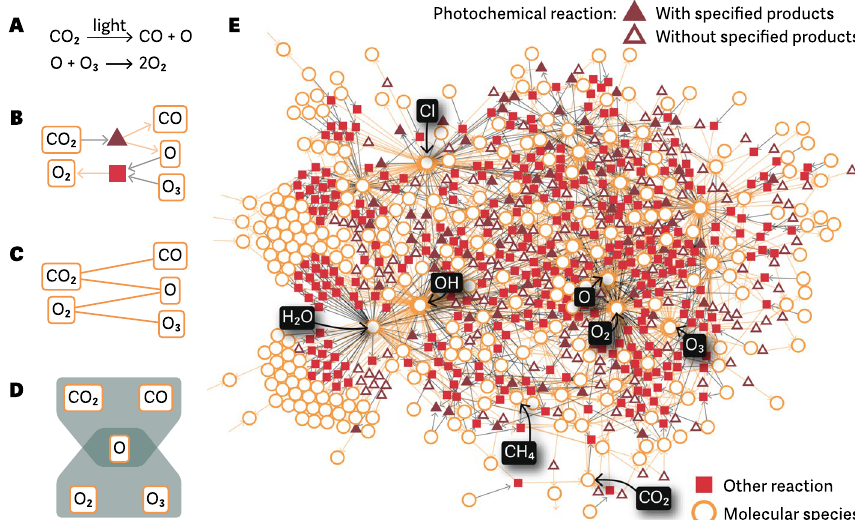
Fig. 4 Network structure of Earth’s atmospheric reaction system. Panel A shows a minimal reaction system comprising of two reactions. Panel B illustrates a representation with two types of reaction nodes (photochemical and non-photochemical). Panel C shows the most common projection to a simple graph. Panel D displays a higher-order network representation (Battiston et al. 2020) where the molecular species involved in one reaction form a hyperedge—a generalization of edges to represent the interactions of an arbitrary number of elements. Panel E shows the atmospheric reaction network of Earth (data from Ref. Solé and Munteanu (2004)) in a representation similar to panel